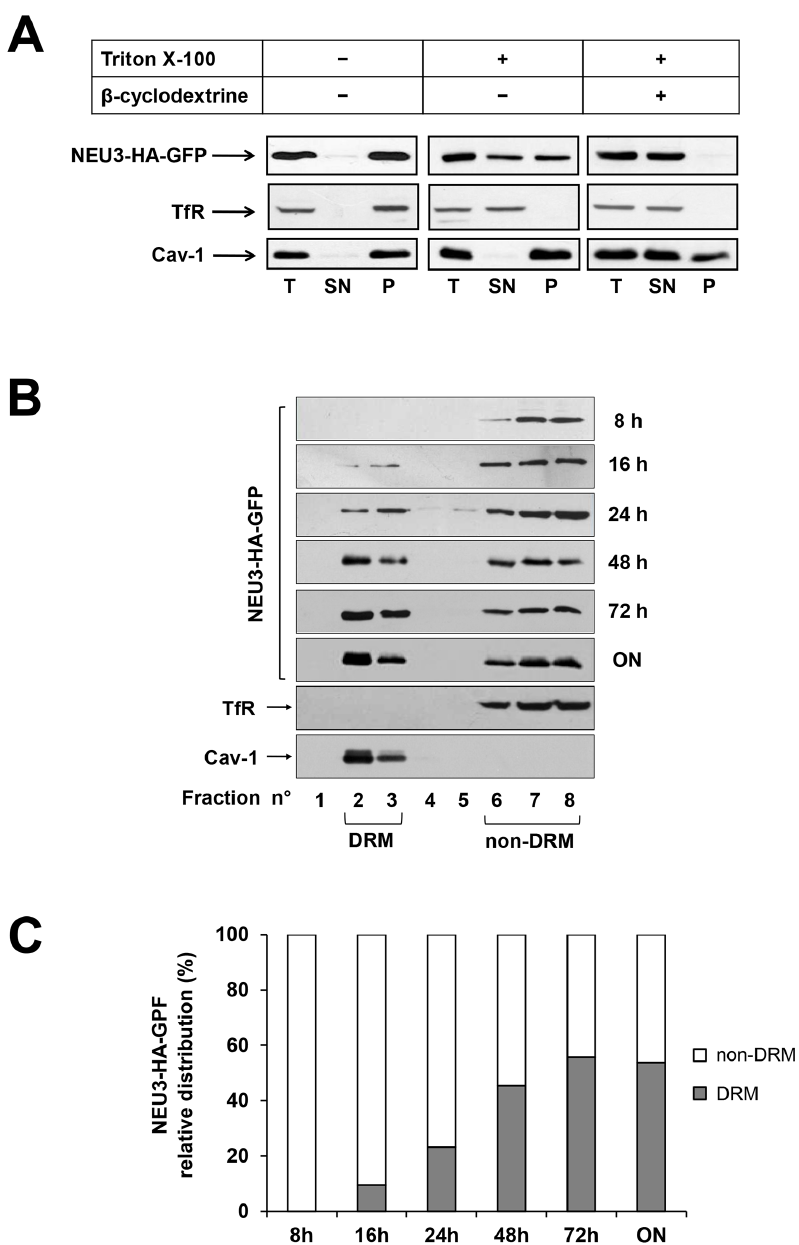
Figure 3. Association of NEU3-HA-GFP to DRM and non-DRM. (A) ON HeLa tTA2 NEU3-HA-GFP grown for 1 h in absence or presence of beta- cyclodextrine were extracted in the appropriate buffer, containing or not 1% Triton X-100 for 30 min at 4 u C and ultracentrifuged for 1 h at 100,000 6 g, Equal amounts of total (T), supernatant (SN) and pelleted (P) material was analyzed by western blot using anti-HA, anti-Transferrin Receptor (TfR) and anti-caveolin-1 (Cav-1) primary antibodies. (B) OFF HeLa tTA2 NEU3-HA-GFP were grown in absence of dox for the indicated time periods and extracted in the appropriate buffer containing 1% Triton X-100 for 30 min at 4 u C. DRM and non-DRM were separated by Opti-Prep density gradient centrifugation. Equal amounts of each gradient fraction were analyzed by western blot as indicated in (A). (C) Relative distribution of NEU3-HA-GFP between DRM (fractions 2 and 3) and non-DRM (fractions 6 to 8) referred to the optical density of bands in (B).